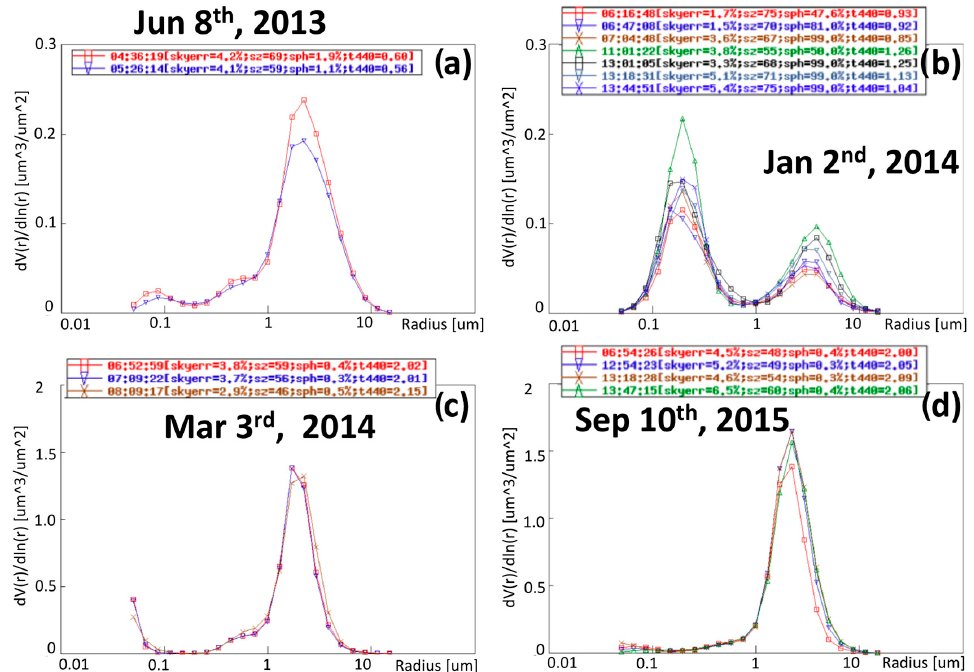
Figure 6. Size distributions of aerosols during ( a ) 8 June 2013 ( b ) 2 January 2014, ( c ) 3 March 2014, and ( d ) 10 September 2015, respectively. Lines in different colors represent different observations during the day.